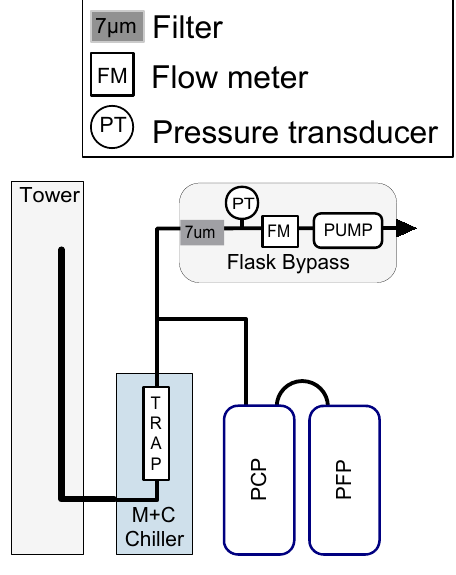
Fig. E1. Diagram of the PFP flask-sampling system.